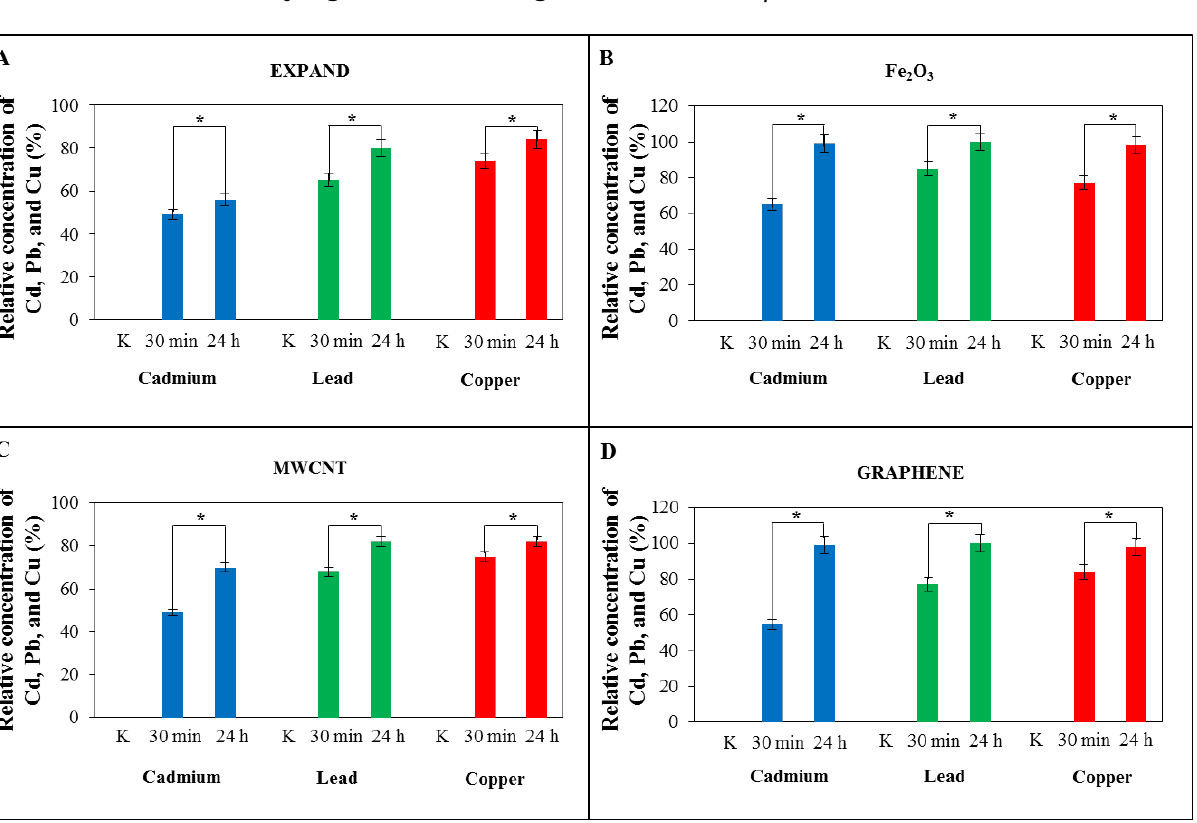
Figure 4. The comparison of time interaction of heavy metal with different adsorbents ( A ) expanded carbon; ( B ) MPs Fe O ; ( C ) multi-walled carbon nanotubes and 2 3 ( D ) graphene (reduced graphene oxide). All values were related to the applied concentration of heavy metals (100 µM for cadmium, lead, and copper). K on the x-axis is control. * Statistically significant at the significance level of p <